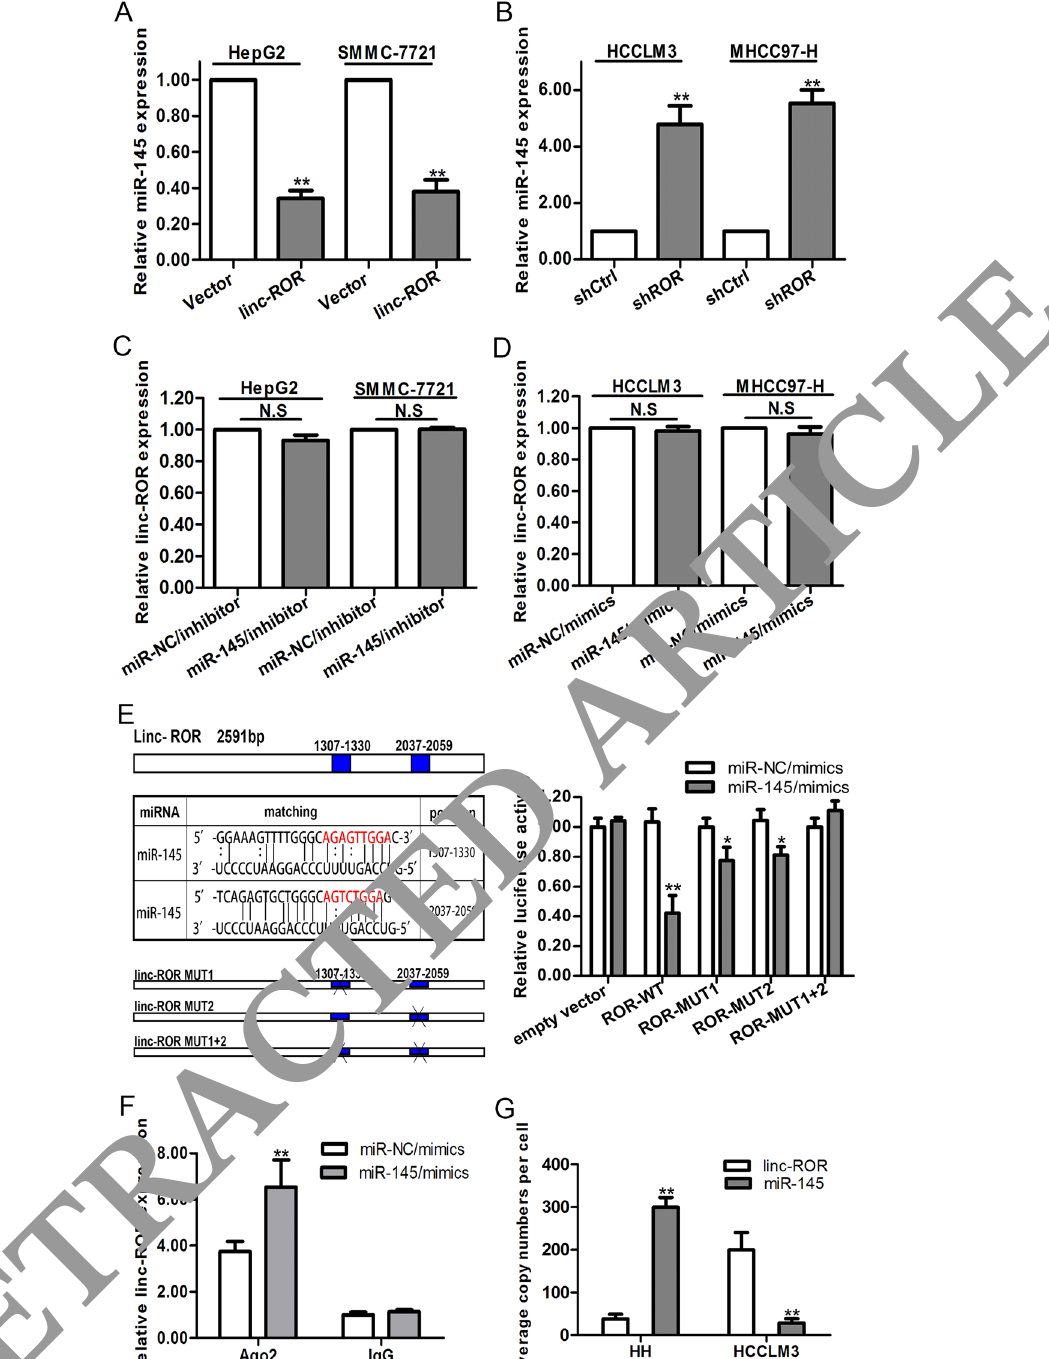
Figure 4. Linc-ROR acts as a molecular sponge for miR-145. ( A ) and ( B ) qRT-PCR detection of miR-145 expression in Vector or linc-ROR transfected HepG2 or SMMC-7721 cells and shCtrl or shROR transfected HCCLM3 or MHCC97-H cells. U6 was used as an internal control. ( C ) and ( D ) qRT-PCR detection of the expression of linc-ROR in miR-NC/inhibitor or miR-145/inhibitor-transfected HepG2 or SMMC-7721 cells and miR-NC/mimics or miR-145/mimics-transfected HCCLM3 or MHCC97-H cells. GAPDH was used as an internal control. ( E ) Left: prediction for miRNA-binding elements on linc-ROR by Miranda. The red nucleotides (target sites) were deleted in the mutant constructs. Right: luciferase activity in HepG2 cells co- transfected with miR-145/mimics and luciferase reporters containing empty vector, ROR-WT, ROR-MUT1, ROR-MUT2, ROR-MUT1 + 2. Data are presented as the relative ratio of firefly luciferase activity to Renilla luciferase activity. ( F ) RNA-IP with anti-antibody was performed in HepG2 cells transfected with miR-NC/ mimics and miR-145/mimics. ( G ) The exact copy numbers of linc-ROR and miR-145 in HH and HCCLM3 cells were quantified with real-time quantitative RT-PCR. For exact quantification of gene copies per cell,